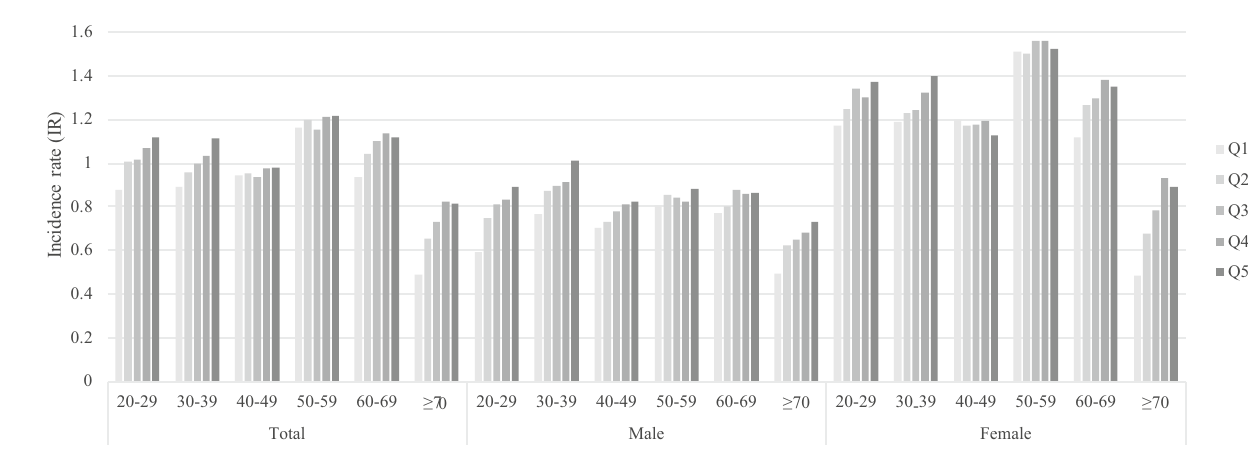
Figure 1. Unadjusted incidence rate of anosmia according to 10-year age group at baseline, sex and height (in quintiles).